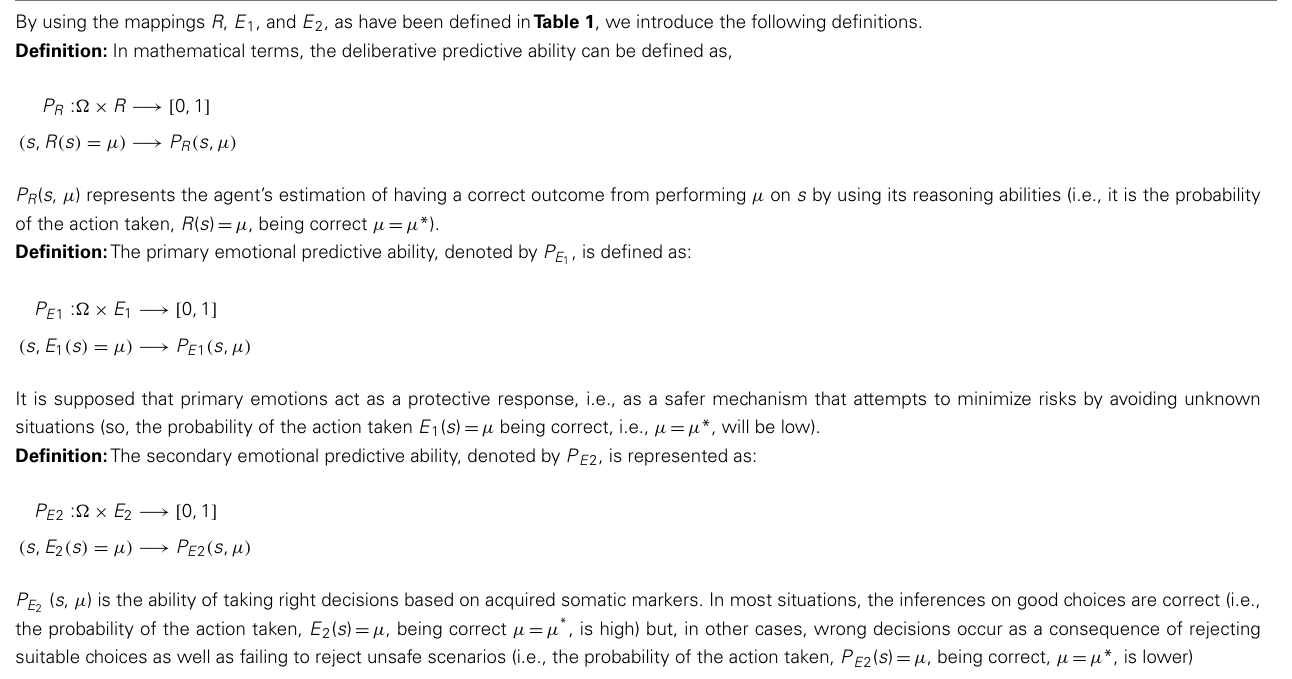
TableA2 | Mathematical definitions of predictive (deliberative, primary, and secondary) capabilities measuring the probability of the action taken being correct.